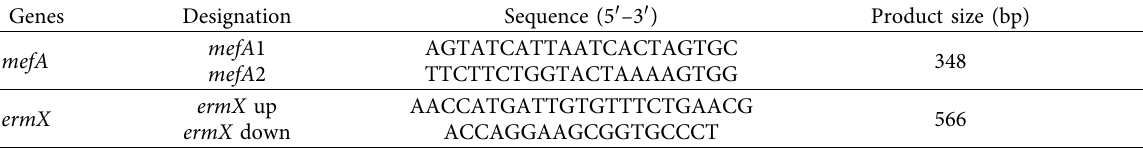
Table 1: Primers for amplifcation of genes.